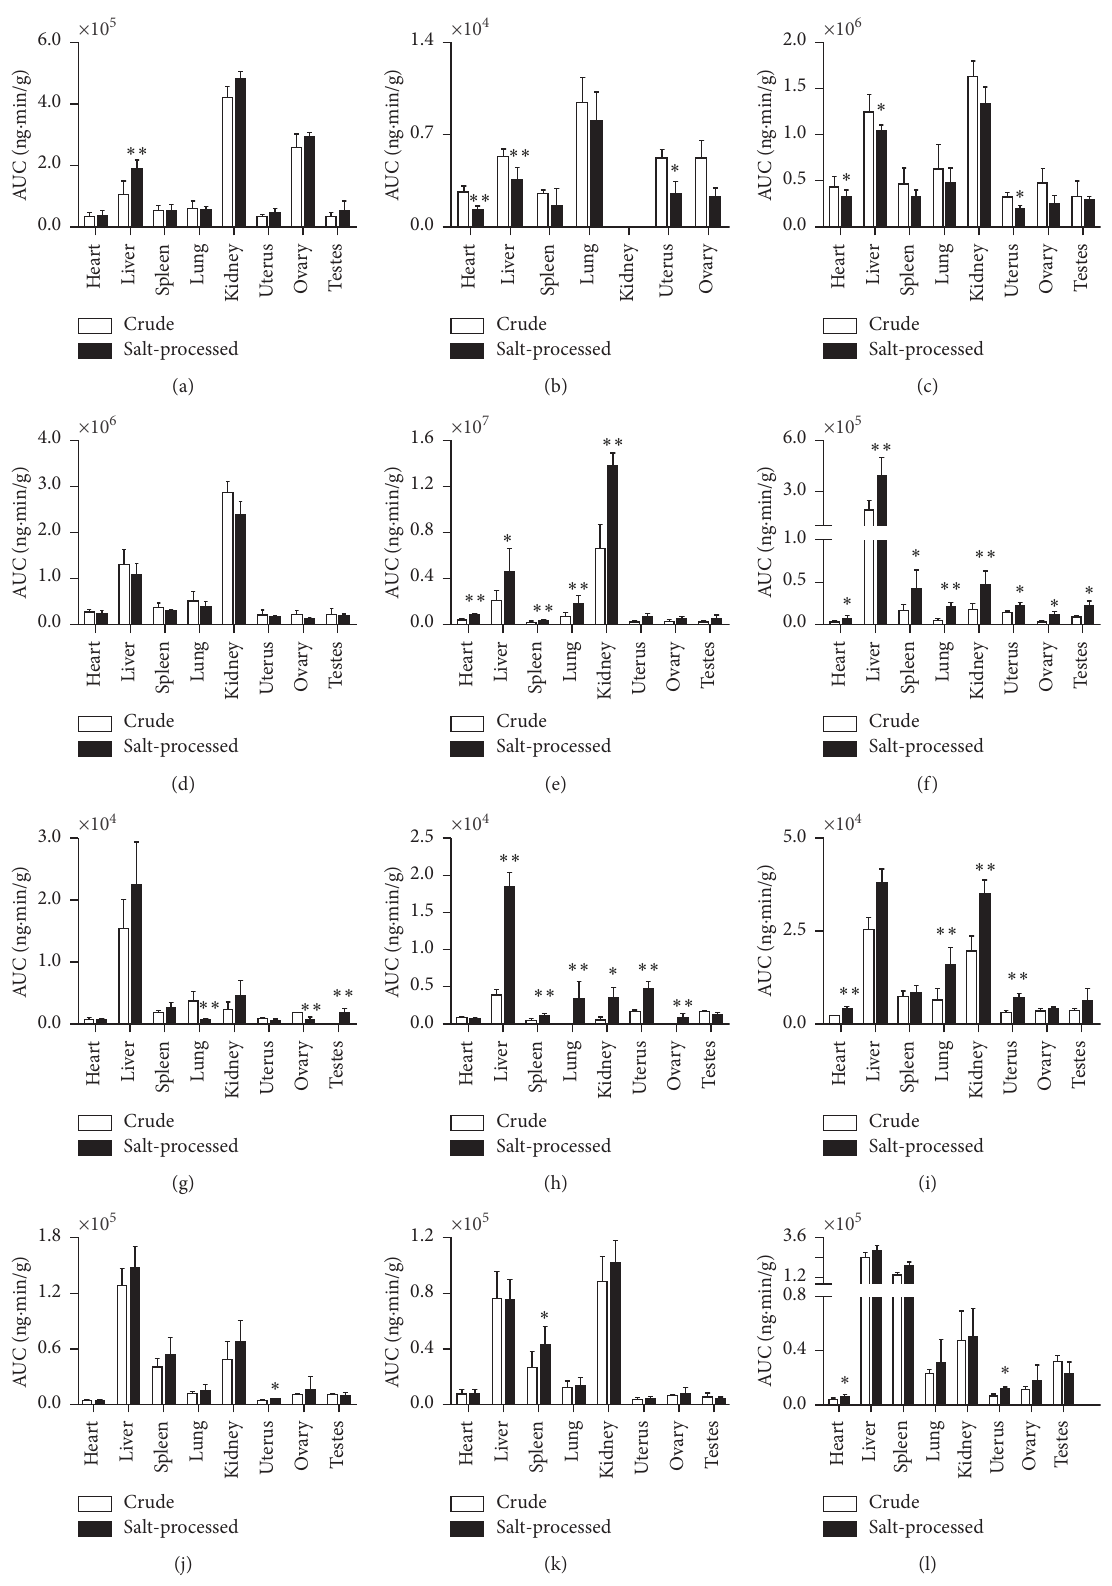
Figure 3: The AUC profiles of 12 kinds of compounds in crude and salt-processed Qing’e pills in rat tissues ( n � 3 for sexual organs and n � 6 for other tissues). The salt-processed group compared to the crude group, ∗ p < 0 . 05; ∗∗ p < 0 . 01. (a) Geniposidic acid, (b) pinoresinol diglucoside, (c) psoralen, (d) isopsoralen, (e) psoralenoside, (f) bavachin, (g) isobavachin, (h) bavachalcone, (i) isobavachalcone, (j) neobavaisoflavone, (k) psoralidin, and (l)